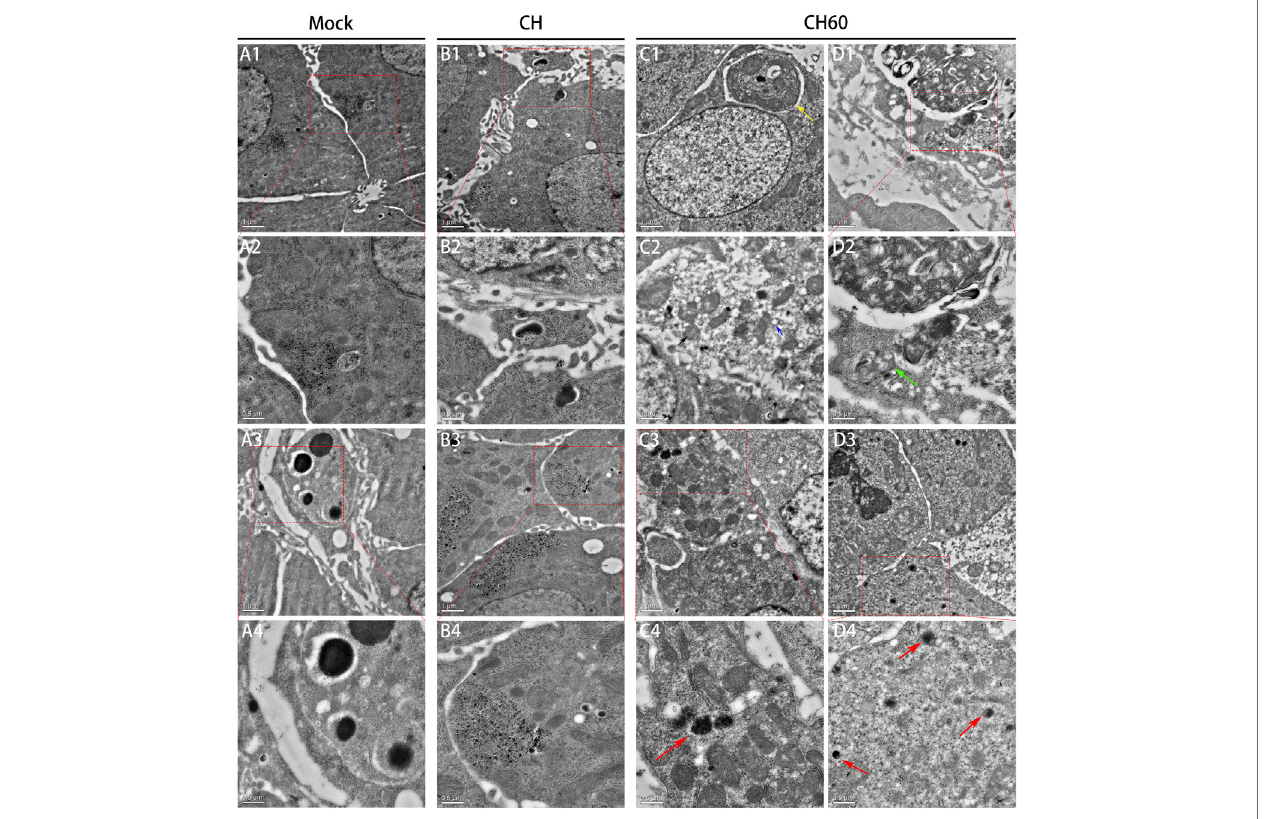
FigUre 2 | Transmission electron microscopy analysis of liver tissue of the mock, CH and CH60 groups at 48 hpi. A: mock group; A2 and A4 are magnifications of the red boxes in A1 and A3, respectively. B: CH group. B2 and B4 are magnifications of the red boxes in B1 and B3, respectively. C and D: CH60 group. C4, D2, and D4 are magnifications of the red boxes in C3, D1, and D3,